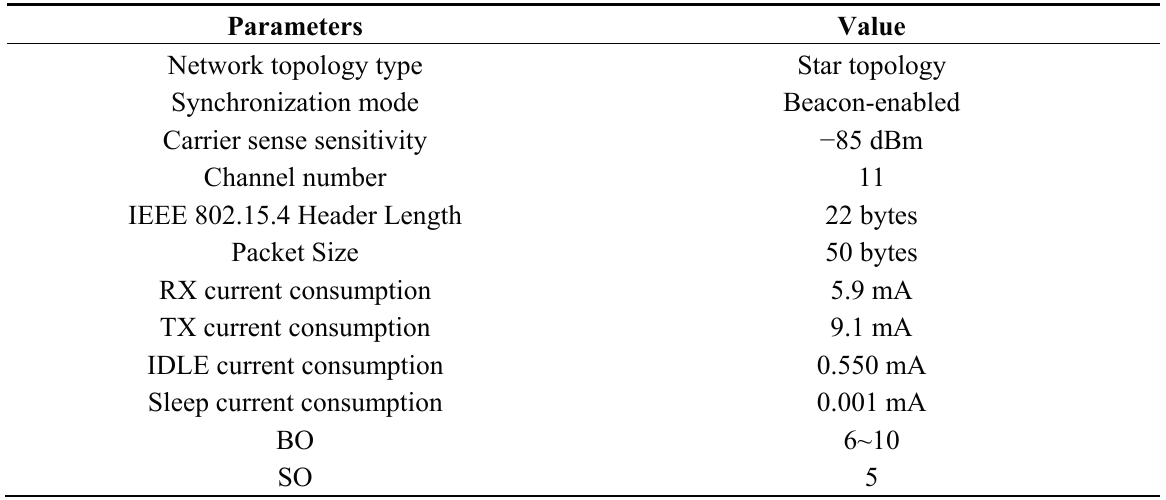
Table 1. Simulation